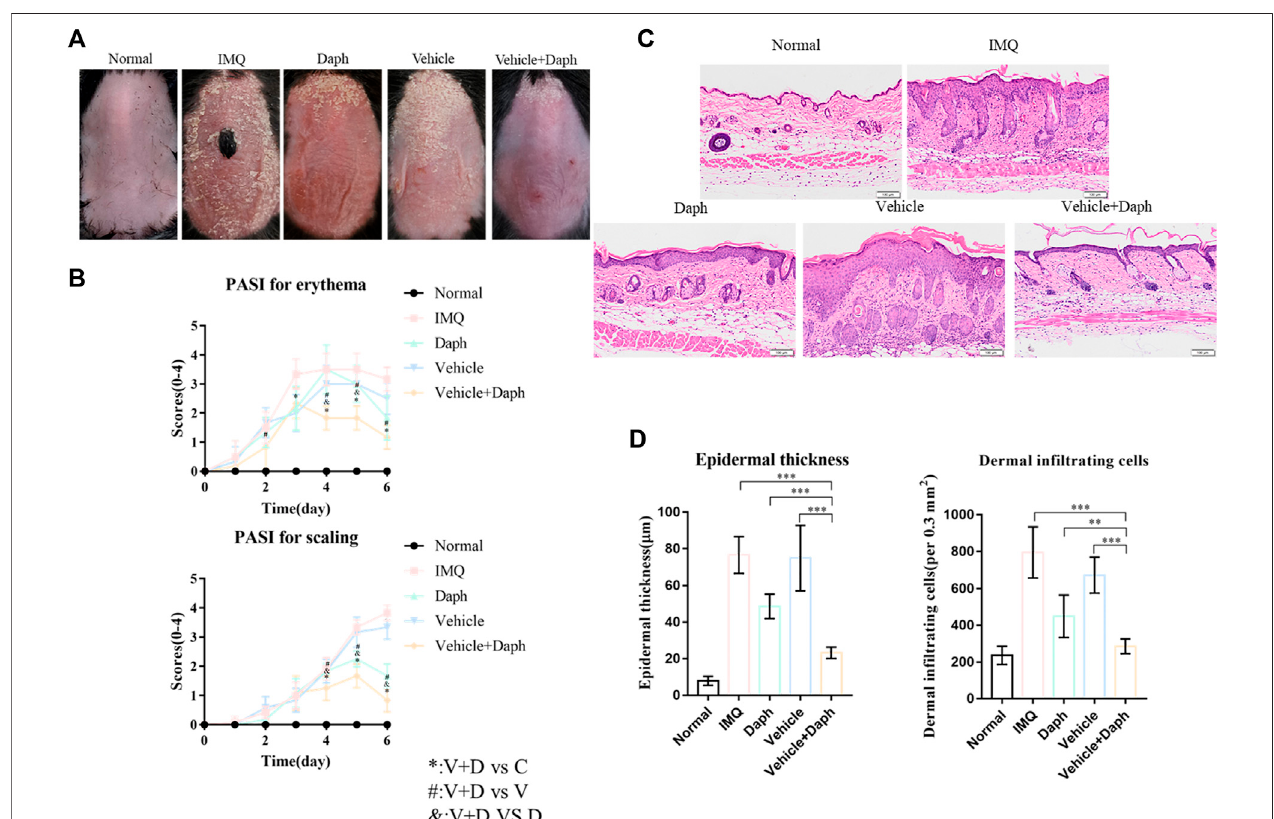
FIGURE 4 | Symptoms and histological results of psoriasis-like mice in different groups. (A) Photos ofpsoriasis modeling sites in different groups of mice. (B) H&E staining of psoriasis models in different groups of mice. (C) PASI scores of psoriatic mice in different groups. (D) Epidermal thickness and the number of in fl ammatory cells in each group. Data are shown as mean ± SE (* p < 0.05; ** p <